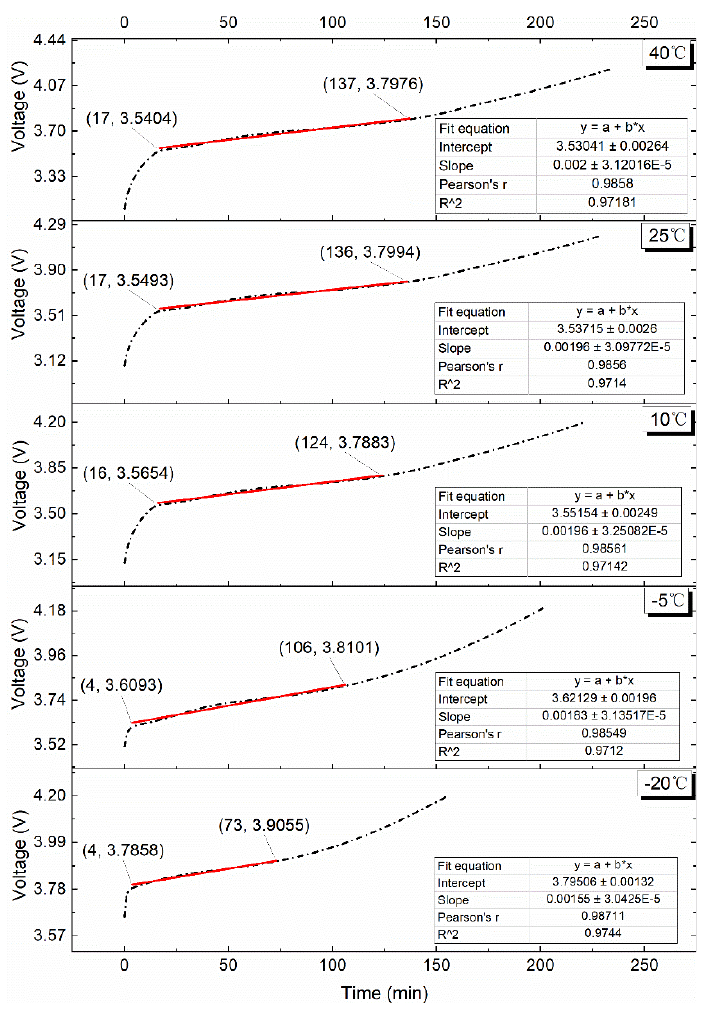
Figure 9. Effect of various temperatures on the VPP at 0.25C charging.